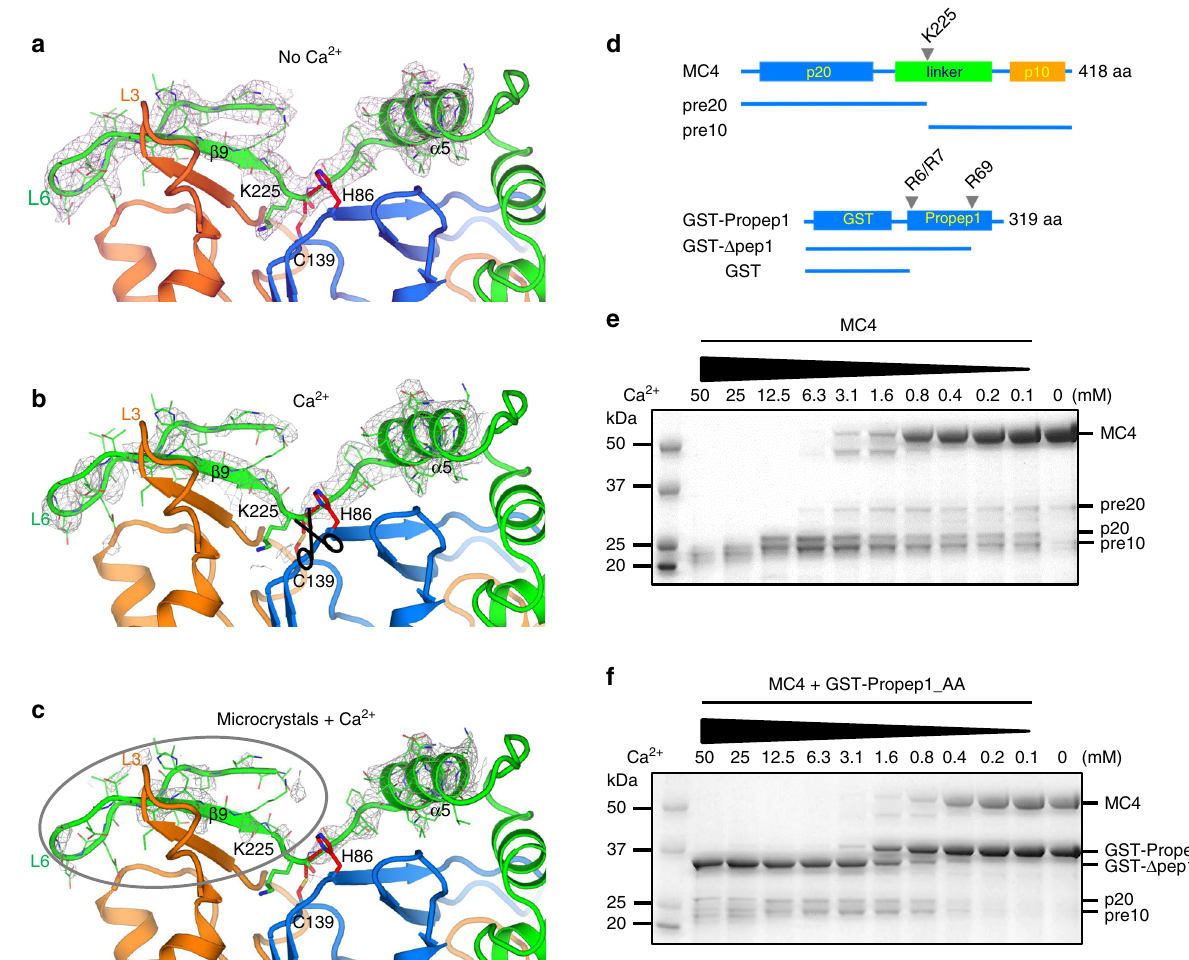
Fig. 2 Ca 2 + -dependent self-cleavage and activation. a – c Electron densities for Ca 2 + -dependent self-cleavage and activation in crystals. The electron densities were drawn as gray isomeshes contoured at 1.3 σ . The distances between the catalytic dyad (His86 and Cys139) and the cleavage site of Lys225 carbonyl carbon are 3.2 Å and are shown as red dashes. a Without Ca 2 + . b With 10 mM Ca 2 + . c With 10 mM Ca 2 + by using microcrystals. d Schematics of major fragments produced in self-cleavage of At MC4 and its cleavage of GST-fusion of substrate Propep1 (GST-Propep1). e Ca 2 + -dependent self-cleavage and activation of At MC4. f Ca 2 + -dependent processing of GST-Propep1 by At MC4. Here a R6A/R7A double mutant in Propep1 is used to highlight the Ca 2 + -dependent cleavage at the site of Arg69. Cleavage of the wild-type GST-Propep1 is shown in Supplementary Fig. 8e where higher concentration of Ca 2 + cleaves Propep1 at an additional site of